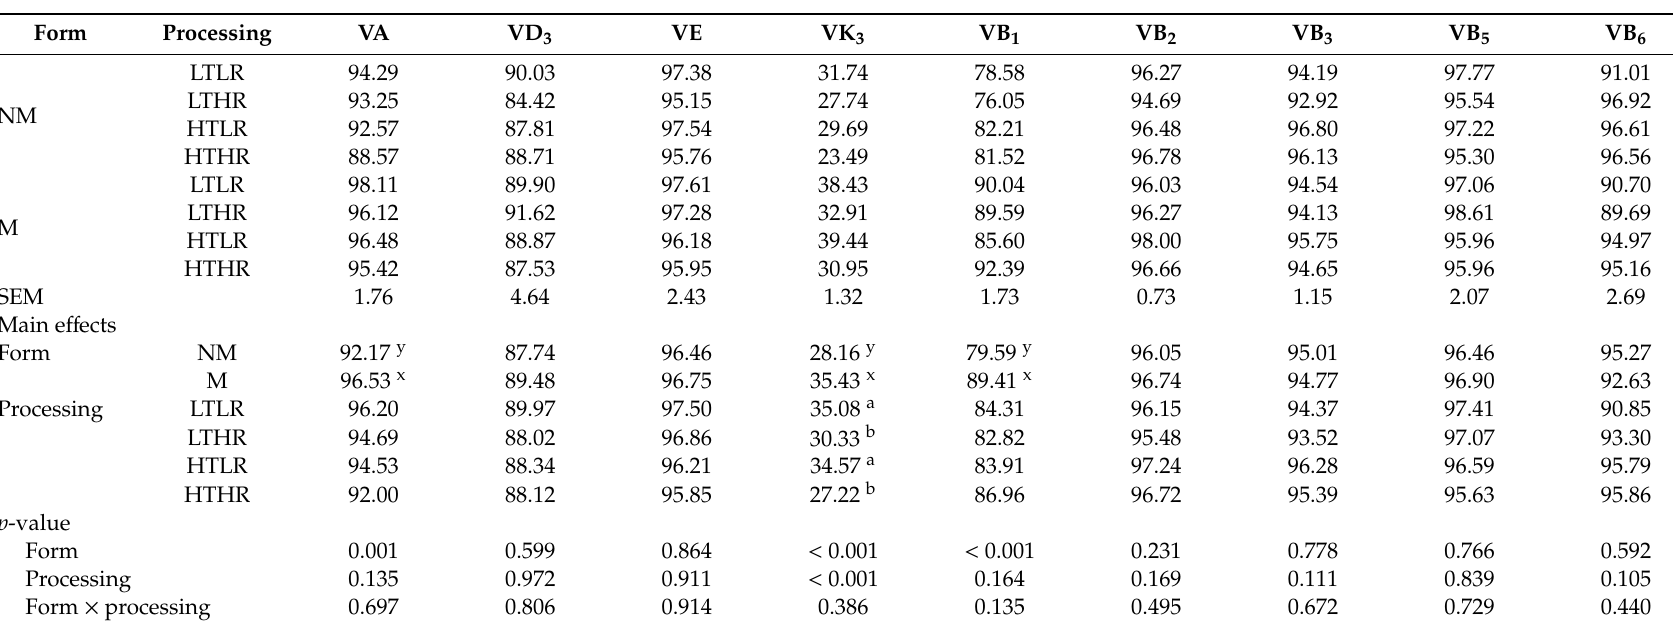
Table 6. E ff ects of pelleting parameters and vitamin forms (non-microencapsulated or microencapsulated) on the percentage of vitamins in diets (Experiment 2) 1 . Form